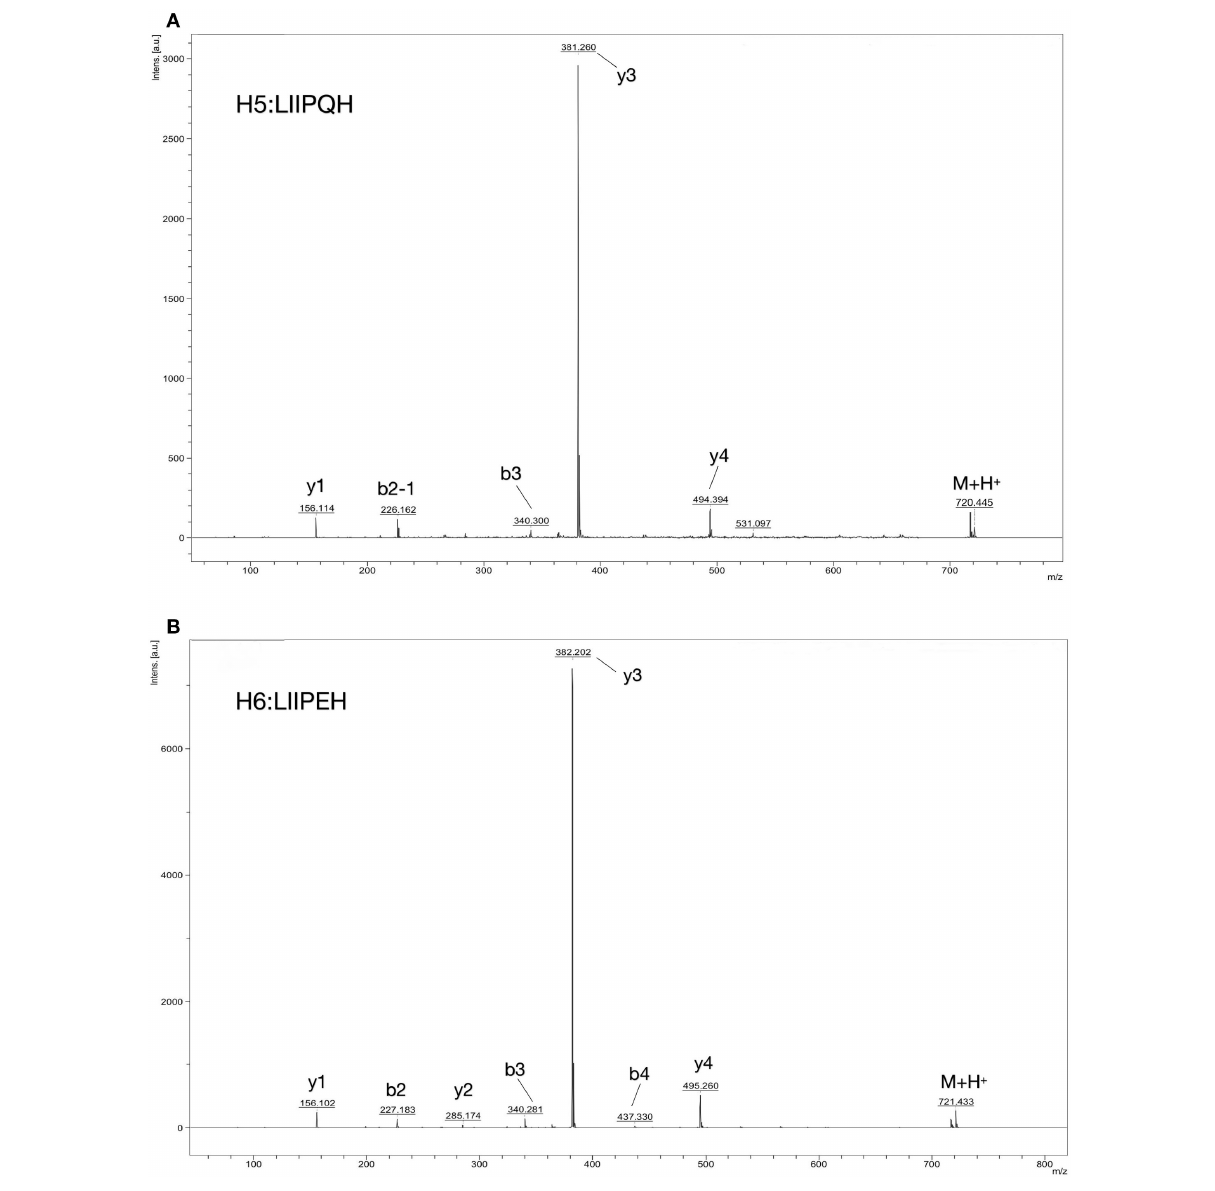
FIGURE 5 | Identification of ACE-inhibition peptides from RWLE using MOLDI-TOF-MS. (A) Molecular mass and amino acid sequence of peptide H5; (B) molecular mass and amino acid sequence of peptide